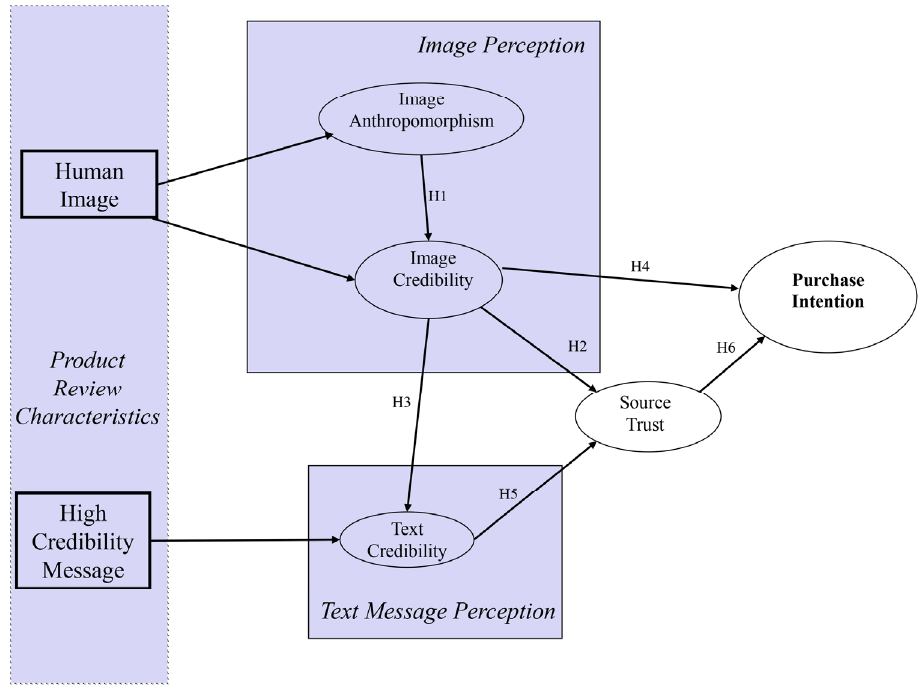
Figure 1. Predicted path